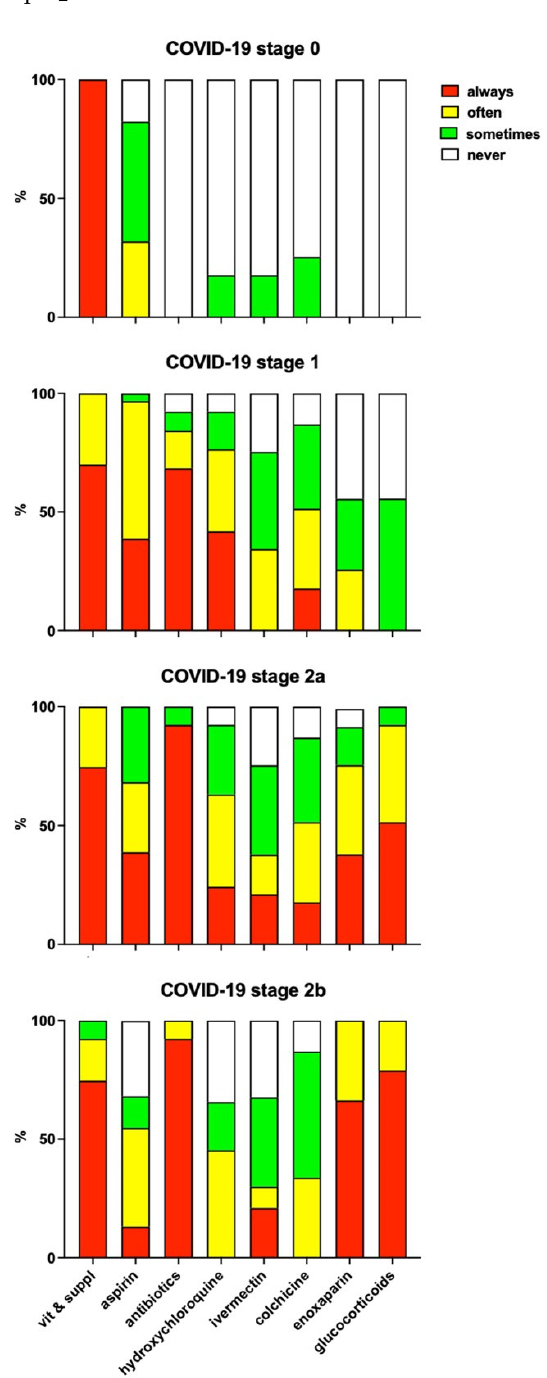
Figure 1. Attitudes of doctors towards the use of drugs, according to the various disease stages. Data is expressed as % of responding doctors weighted for the number of COVID-19 patients included in the present study that each doctor cared for.